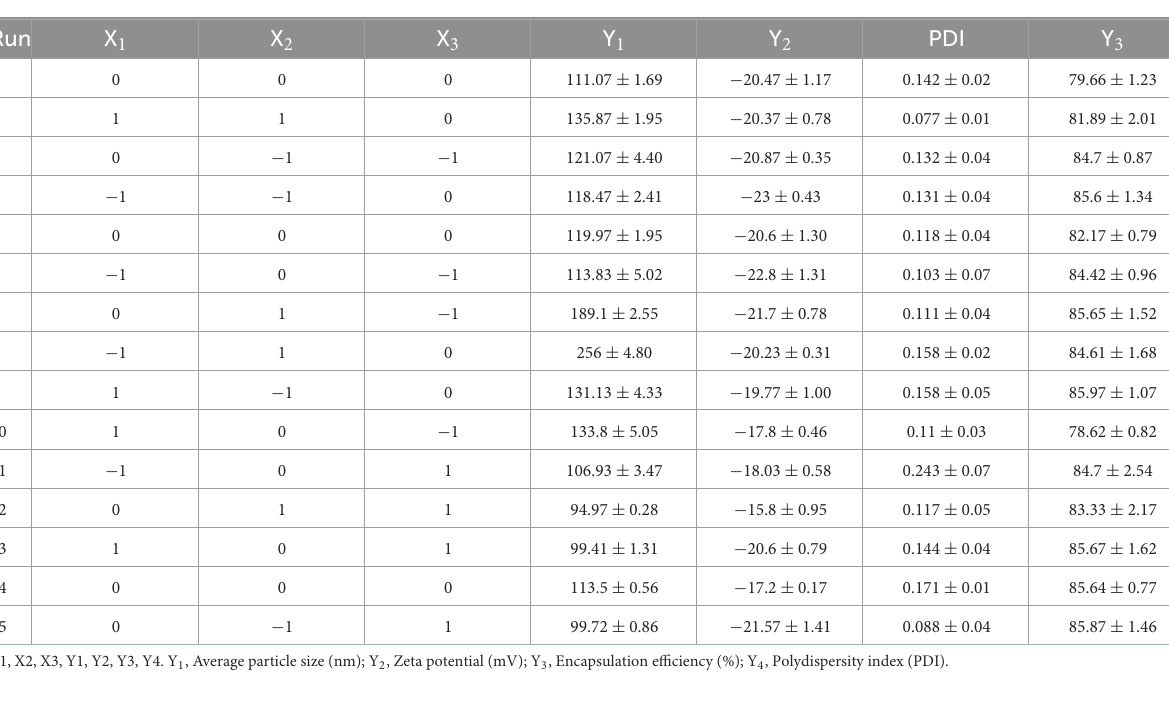
TABLE 2 Box-Behnken design matrix with values and the measured response.